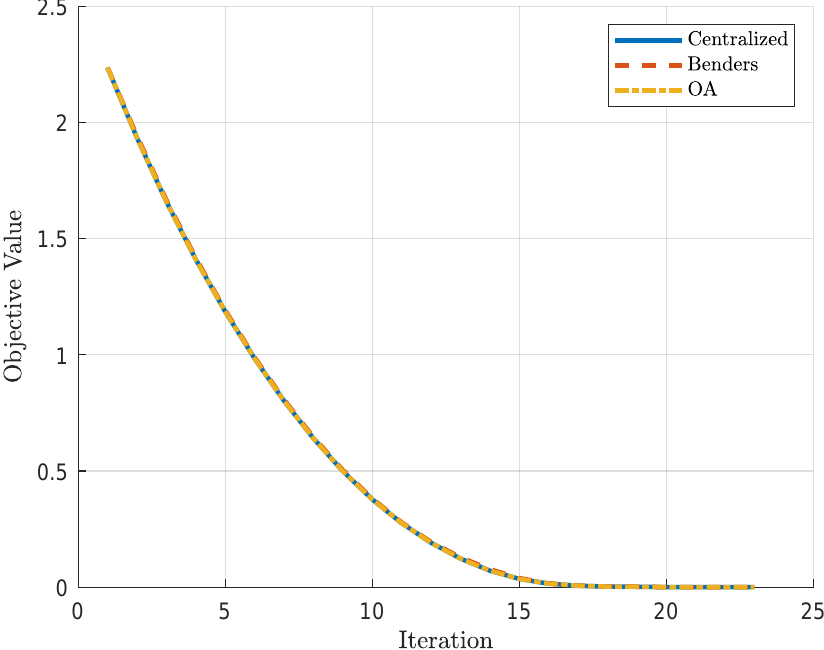
Figure 9. Objective value for the different approaches along the iterations of the